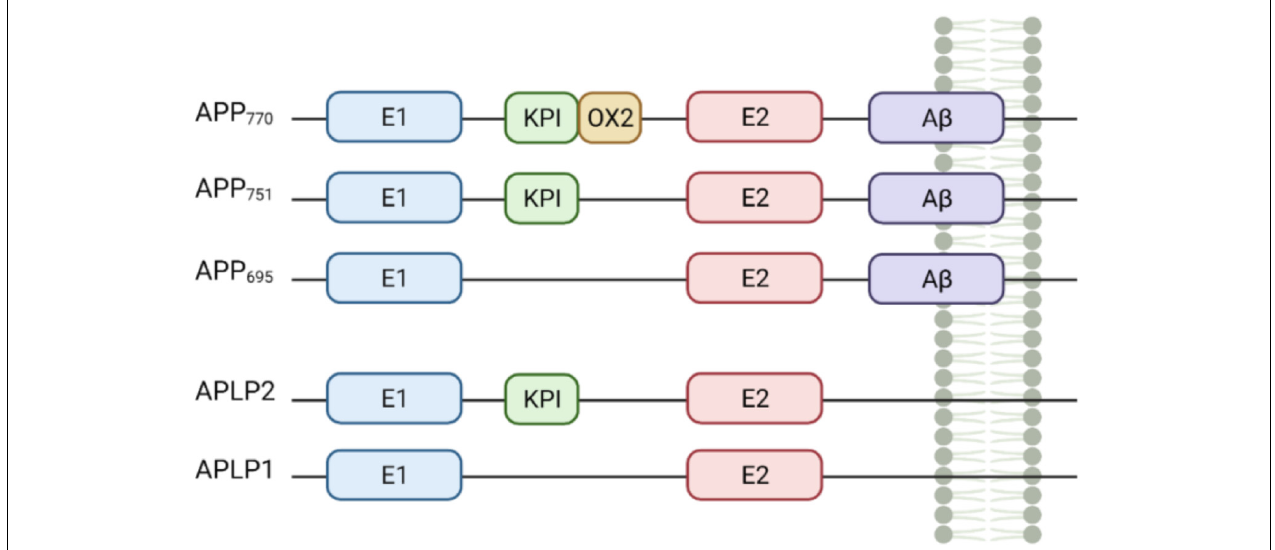
FIGURE 1 | Domains of amyloid precursor protein (APP) and the APP-like proteins (APLP) protein family members. APP and its mammalian homologues APLP1 and APLP2 share similar domain architecture including the E1 and E2-domains, which potentially drive dimerisation. APP770, APP751, and APLP2 are characterised by the Kunitz type protease inhibitor domain (KPI) upstream of E2. APP770 includes also the OX2 domain. Both APP and APLPs contain a transmembrane domain (TMD) but only APPs have the A β sequence (purple). Created with BioRender.com.